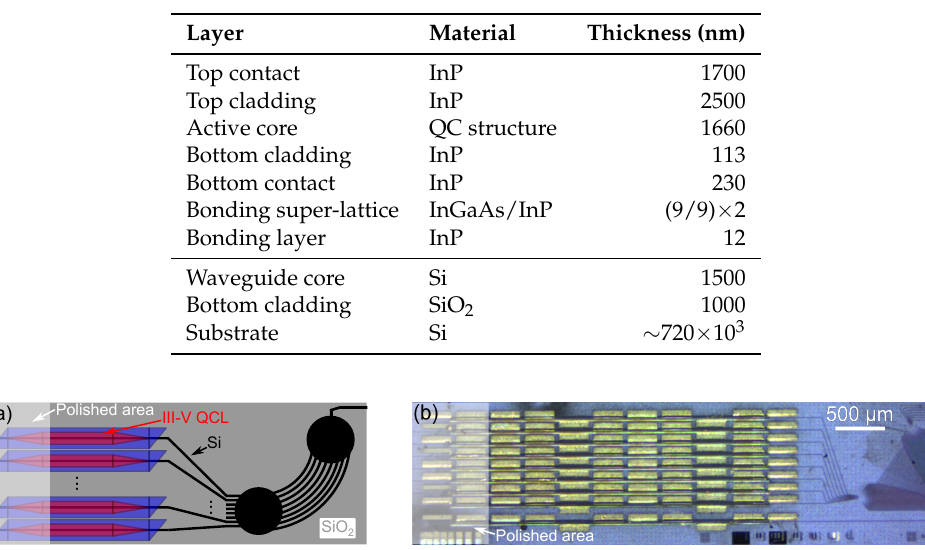
Figure 1. ( a ) Top-view schematic of the QCL array and arrayed waveguide grating (AWG). Mirrors are defined under the red III-V QCL ridges for both the distributed feedback (DFB) and distributed Bragg-reflection (DBR) type lasers. ( b ) Micrograph of a multi-spectral DFB laser, showing the individual lasers on the left and the AWG combiner on the